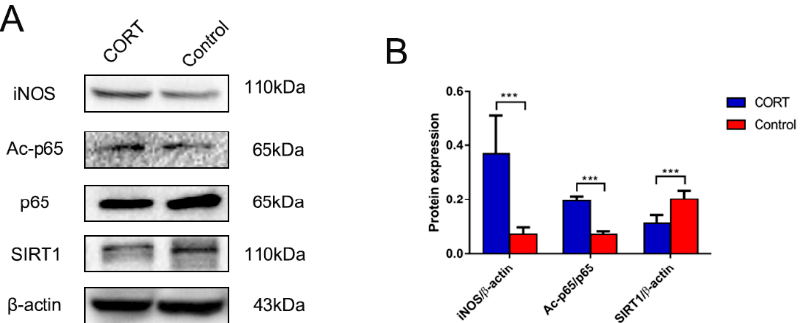
Figure 12. Acetylation and expression of nuclear factor (NF)- κ B signaling pathway components in BV2 cells after cortisol (CORT) treatment (200 µ M) for 3 h, as determined by western blotting. ( A ) iNOS, acetyl-p65 (Lys310), p65, SIRT1, and β -actin expression. ( B ) Quantification of expression levels based on inducible nitric oxide synthase (iNOS) / β -actin, acetyl-p65 / p65, and silent mating type information regulation 2 homolog (SIRT)1 / β -actin ratios. Di ff erences between control and CORT groups were evaluated by one-way analysis of variance. Results are expressed as the mean ± SD ( n = 3) of three independent experiments. *** p < 0.001.